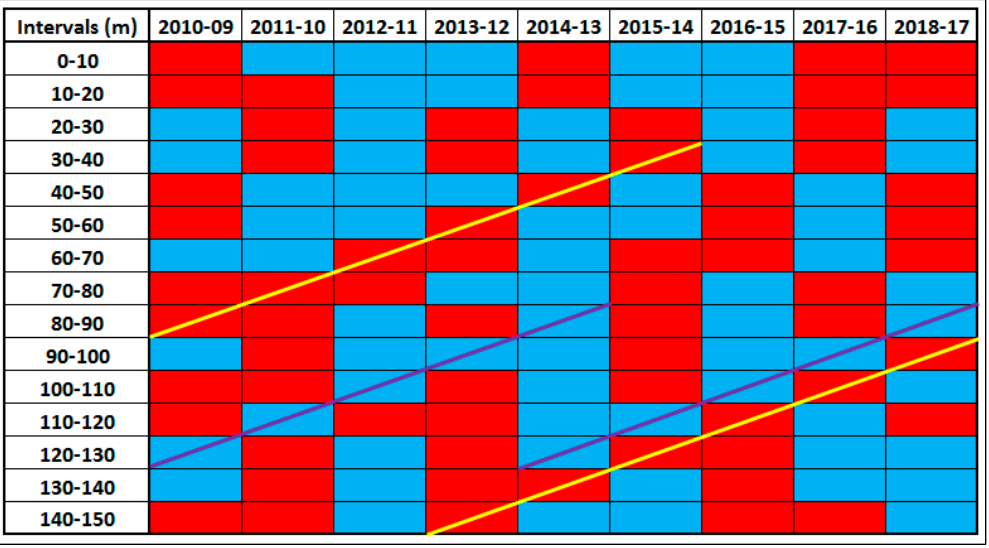
Figure 5. Thickening (U) and thinning (D) in the comparison between two consecutive years (2011–2010) of profile 3 of cone A.